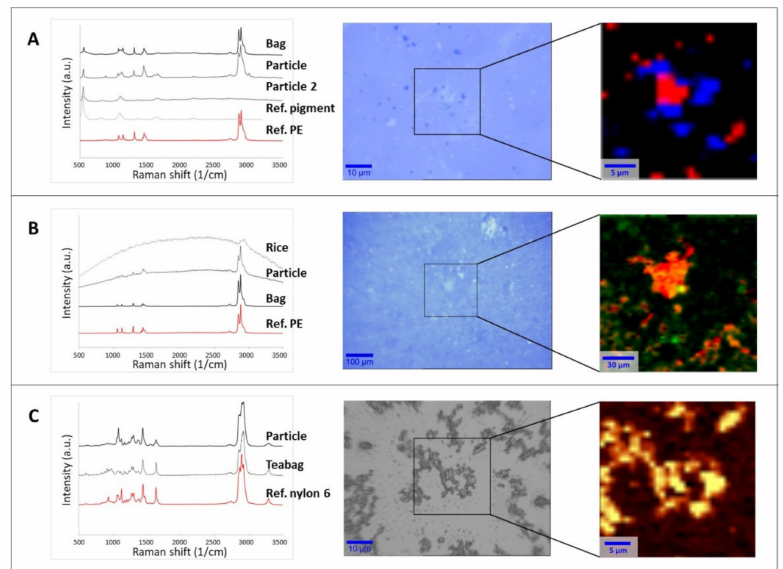
Figure 1. Raman spectral identification (left), optical image (middle), and chemical heat maps (right) of the collected particles released from food packaging materials: ( A ) ice bag, ( B ) rice cooking bag, ( C ) teabag. The rectangular area in the optical images shows the area analyzed by 2D mapping and the subsequent base component analysis or intensity peak heat map. Chemical maps of the filtrate